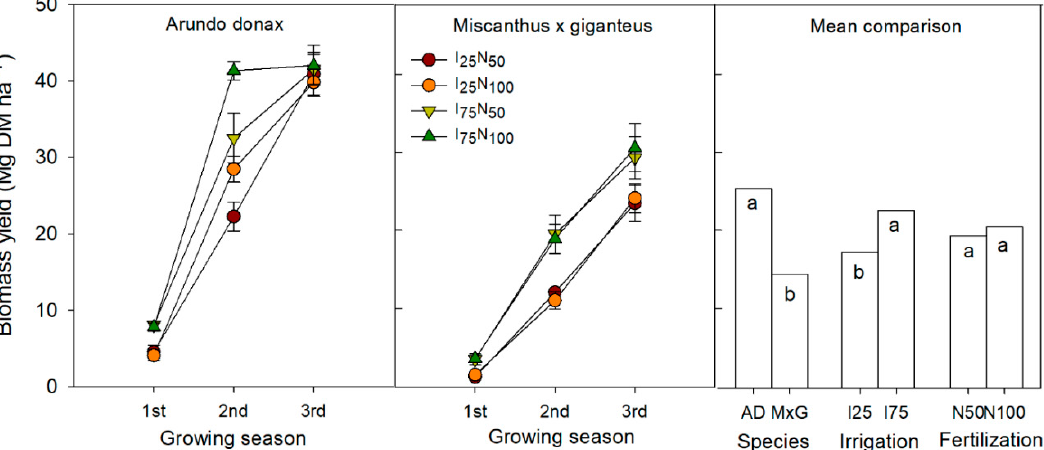
Figure 2. Biomass dry matter yield (Mg DM ha − 1 ) of Arundo donax and Miscanthus × giganteus throughout the experimental period and mean separation of main effects according to the Duncan’s post-hoc test. Different letters within main effect indicate statistical different mean ( p ≤ 0.05).